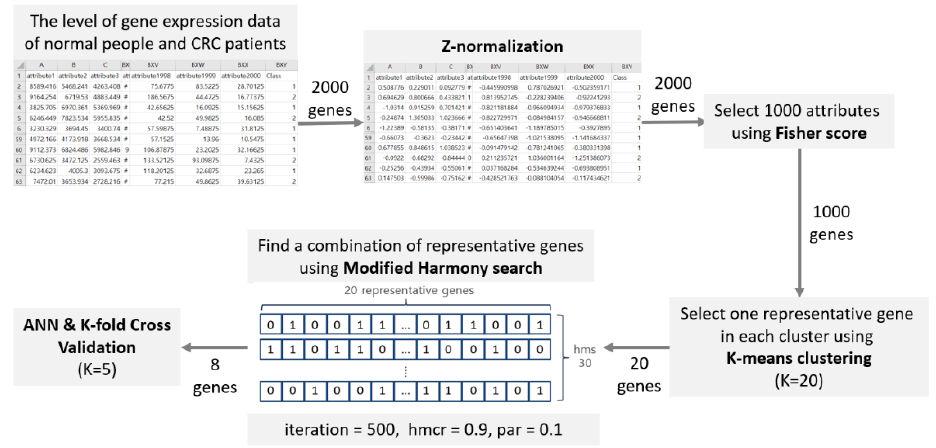
Figure 1. Scheme of proposed methods.